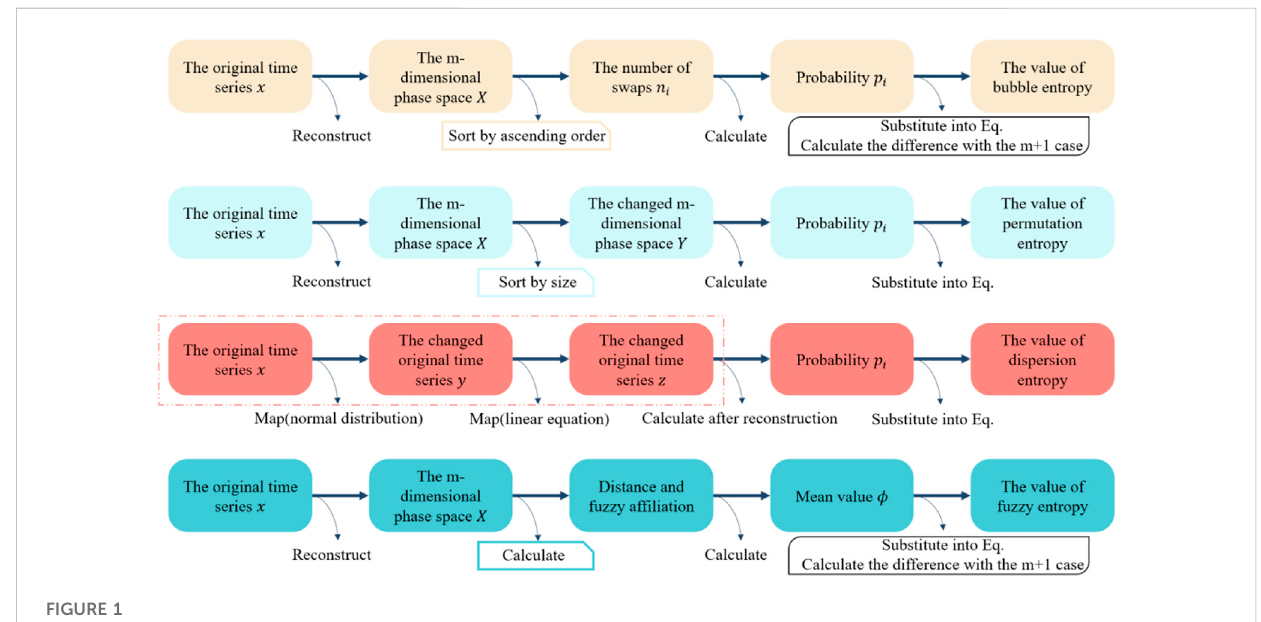
FIGURE 1 Theoretical logic of BE, PE, DE, and